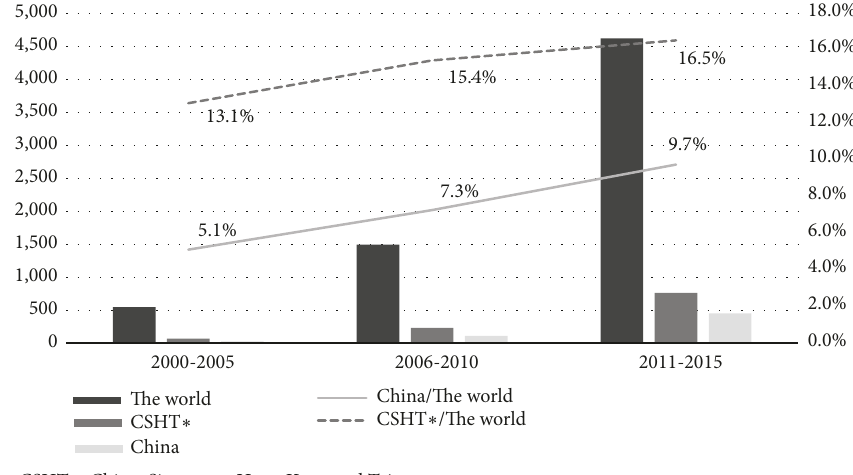
Figure 3: Contribution of Countries to Maritime Academia.